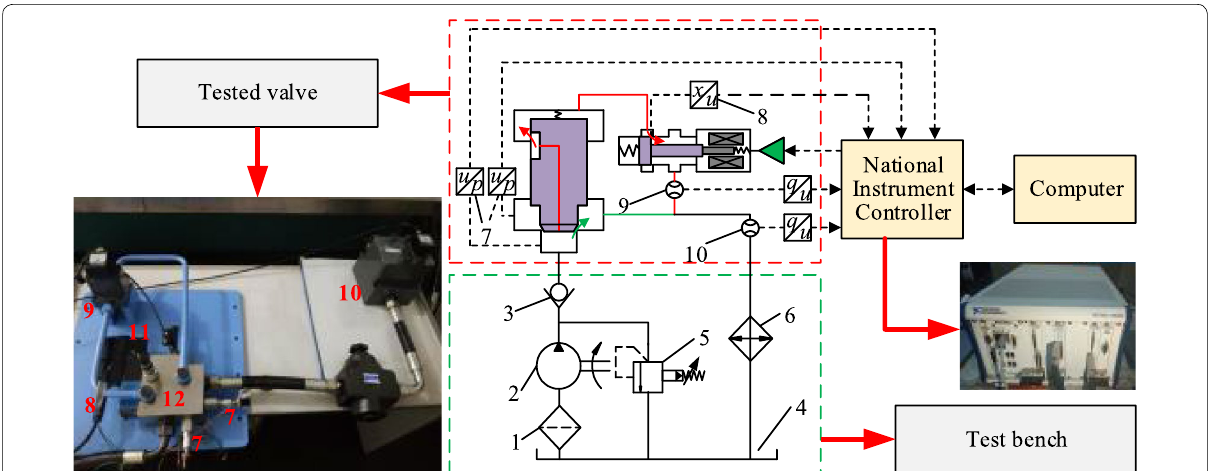
Figure 6 Experimental system of the Valvistor valve: 1. Filter, 2. Variable pump, 3. Check valve, 4. Oil tank, 5. Relief valve, 6. Cooler, 7. Pressure sensor, 8. Displacement sensor, 9. Flow meter for pilot flow, 10. Flow meter for total flow, 11. Pilot valve, 12. Main valve